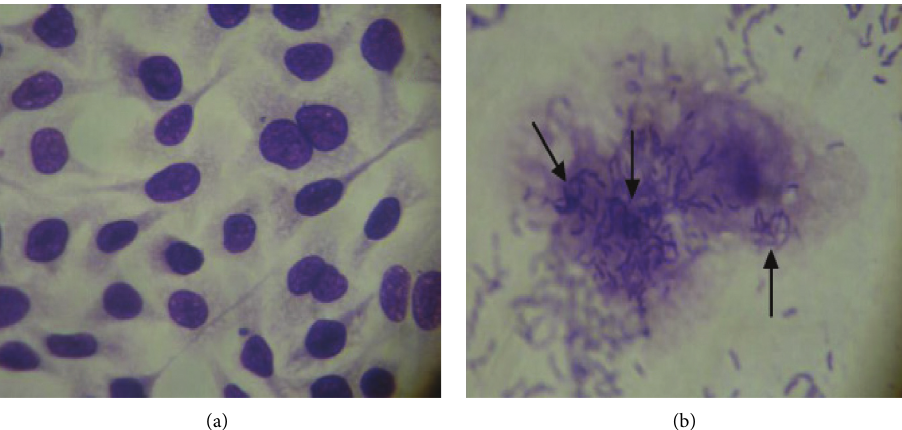
Figure 5: Adherence of V. mimicus to HEp-2 cells. (a) Negative control, HEp-2 cells. (b) Adherence pattern exhibited by the V. mimicus strains (light microscope